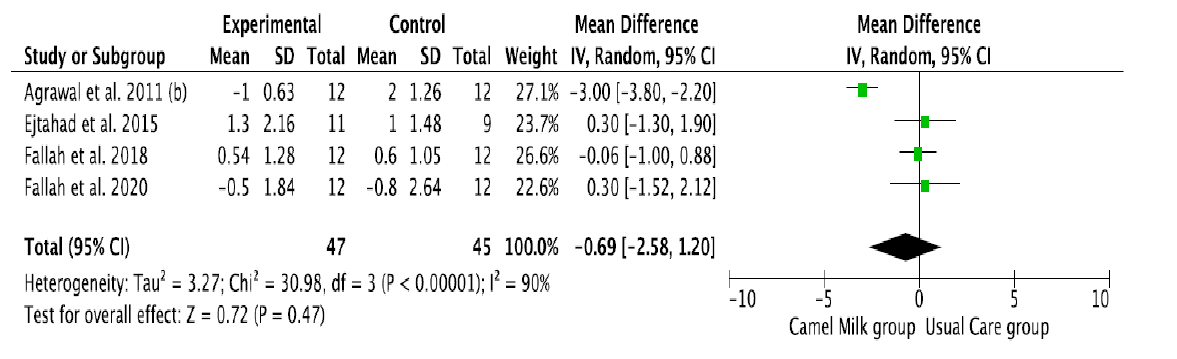
Figure 7. Forest plot for the effect of CM intake on HOMA-IR. (b): difference between the two articles